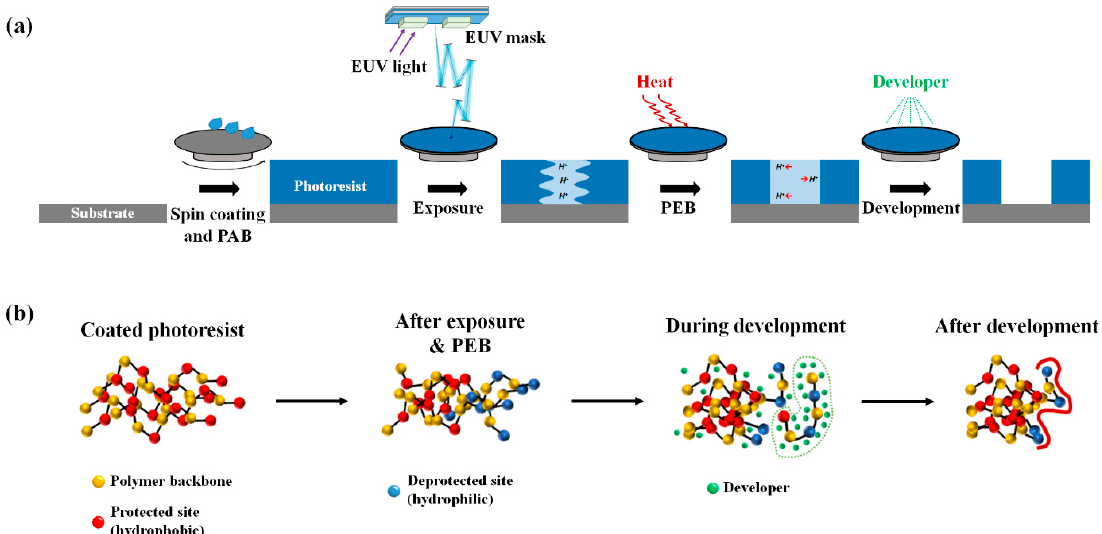
Figure 1. Schematic illustration of the extreme ultraviolet (EUV) lithography process. ( a ) Conventional model of EUV lithography process. ( b ) Our model using coarse-grained molecular simulation. PAB and PEB mean post-applied bake and post-exposure bake, respectively.